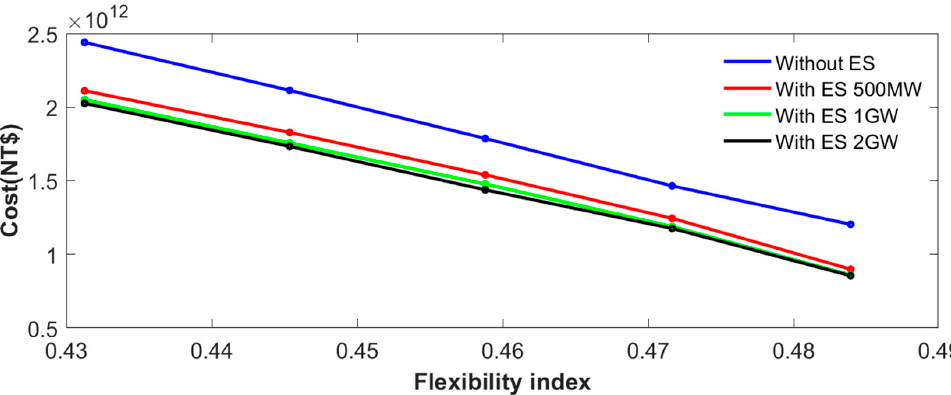
Figure 14. Relationship between multi-scenario unit-scheduling cost and generation flexibility in autumn.